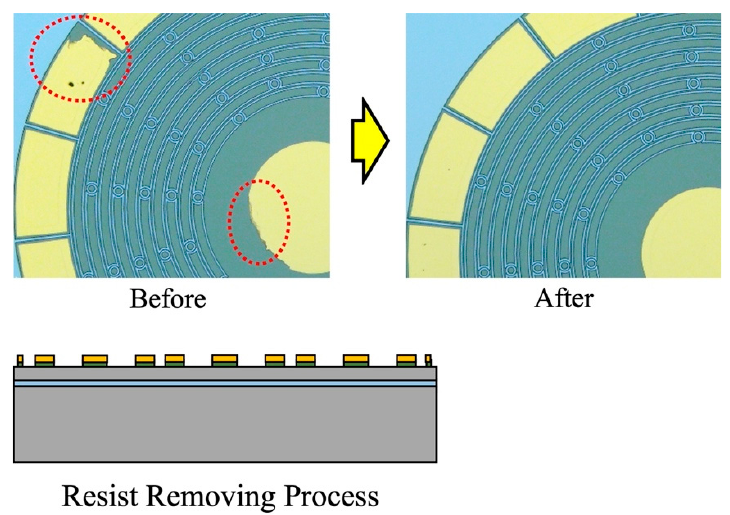
Figure 10. Improvement on fabricated electrodes after applying developed deposition technique.